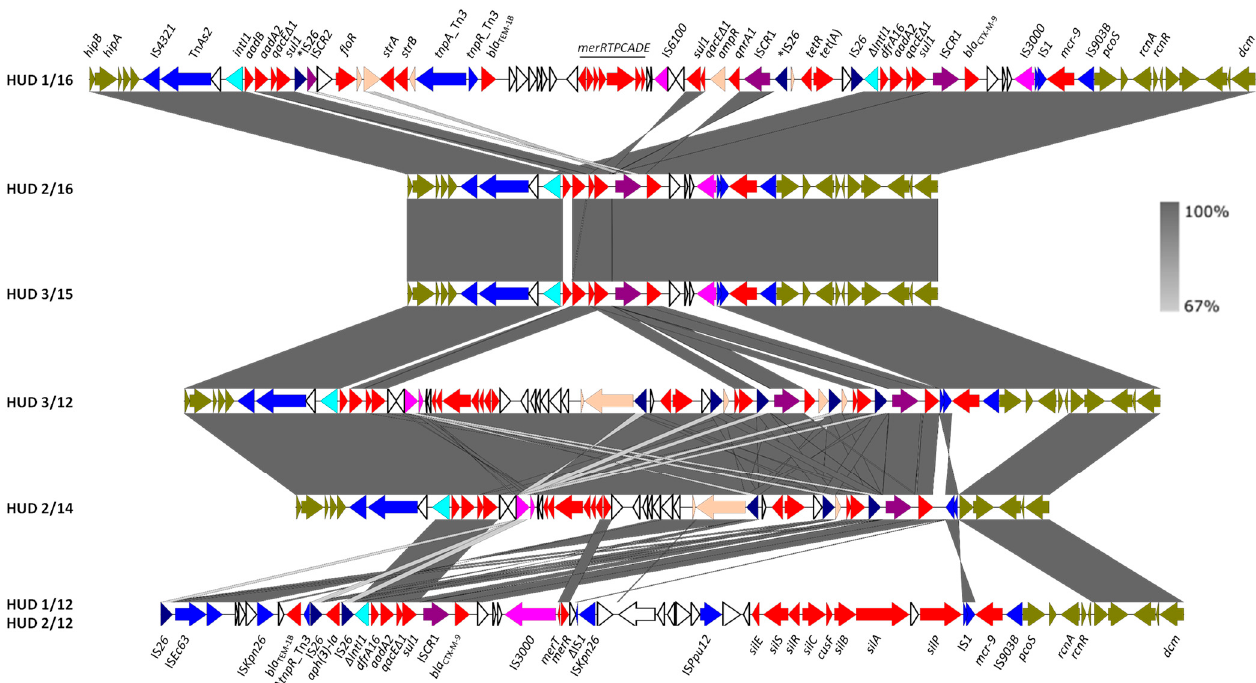
Figure 2. Detailed structure and comparison of the resistance clusters found in the IncHI2-ST1 plasmids of monophasic S . Typhimurium ST34 isolates. Protein coding regions (ORFs) are represented by arrows indicating the direction of transcription and colored according to their function: red, resistance; light blue, DNA mobility, with IS 26 highlighted in dark blue, IS 3000 and IS 6000 in light purple, and IS CR elements in dark purple; orange, other roles; olive green, plasmid ORFs flanking the resistance clusters. The two copies of IS 26, flanked by direct repeats that delineate a fragment that was probably inverted in pHUD 1/16, are marked with asterisks. The alignments were created with EasyFig BLASTn. The gray shading between regions reflects nucleotide sequence identities according to the scale on the figure's right.